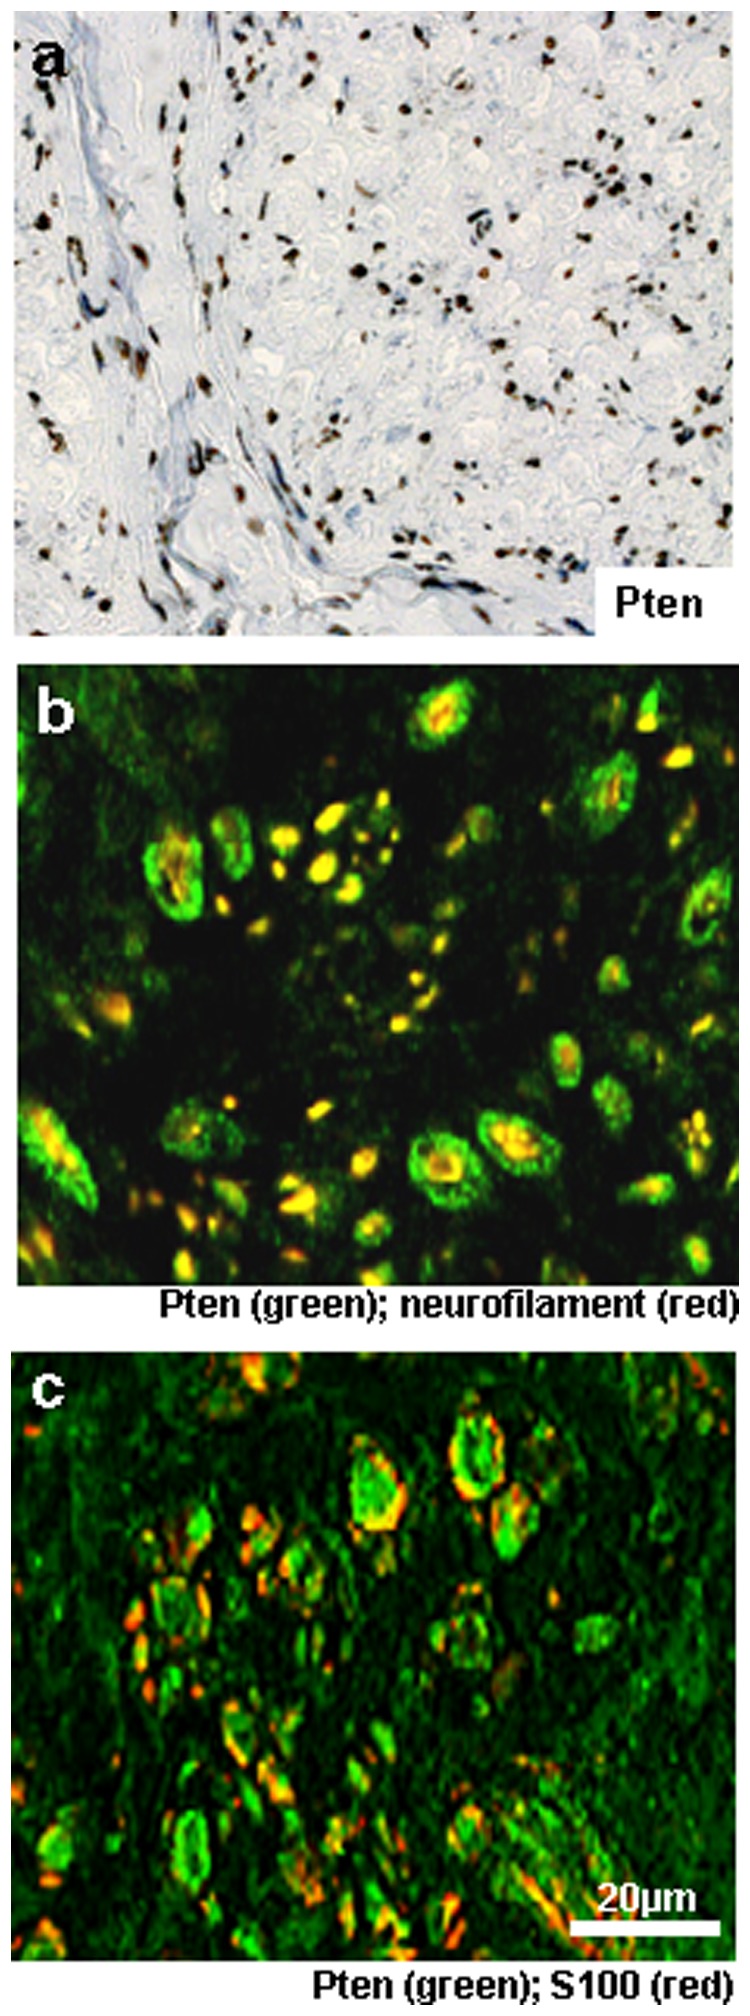
Pten expression in nerve tissue (a-c) and Schwann cell cultures (d).a) Standard DAB staining. b) Double staining for Pten (green) and neurofilament (red). c) Double staining for Pten (green) and S100 (red). Original magnification 400x.